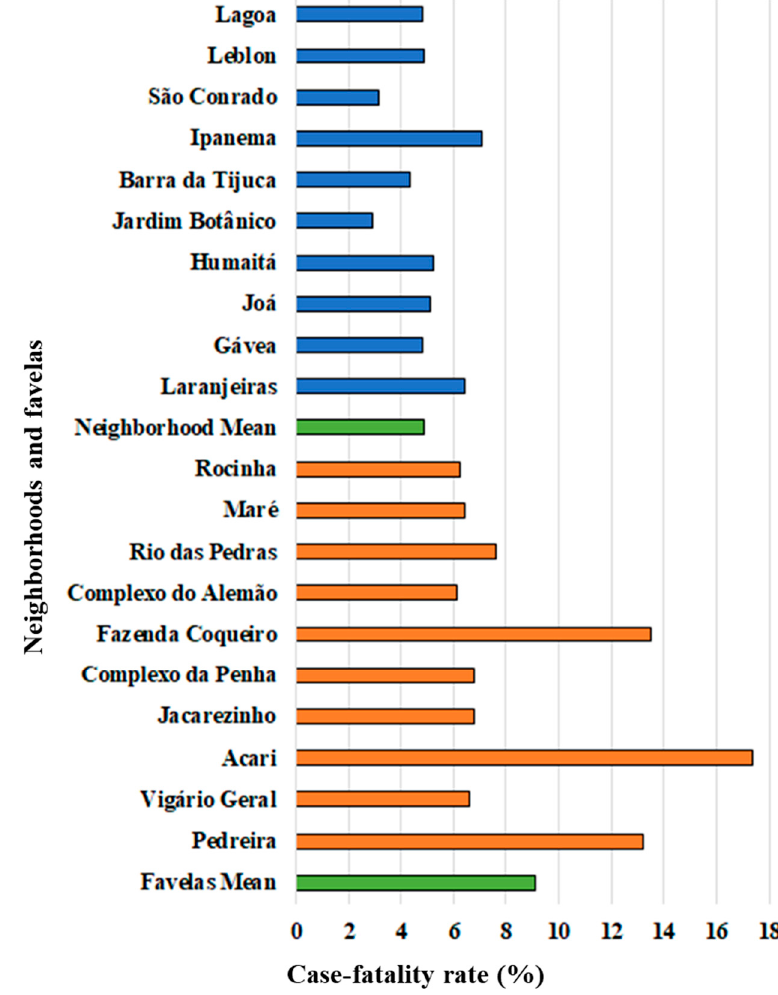
Figure 1. Case-fatality rate (CFR) of COVID-19 in the top 10 highest social developed index (SDI) neighborhoods (blue bars), top 10 most populous favelas of Rio de Janeiro (orange bars), and the average for each scenario (green bars).